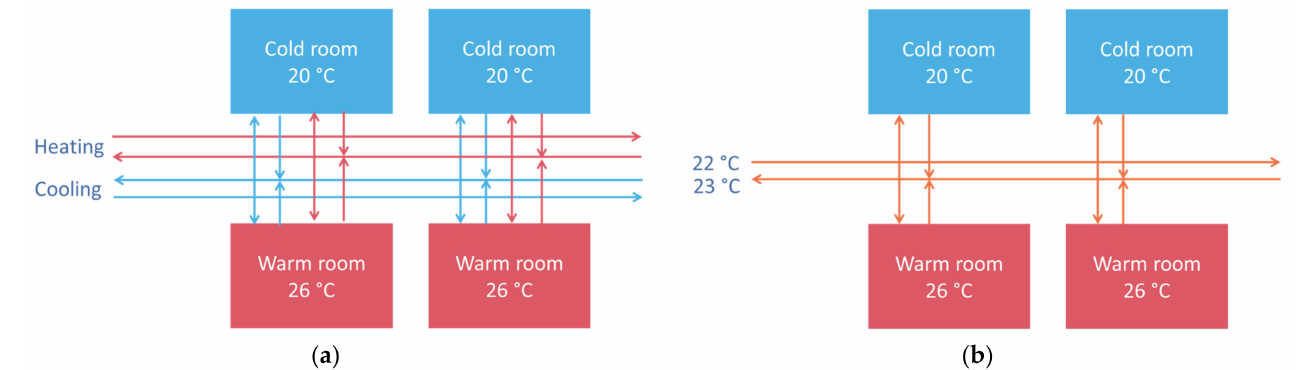
Figure 2. Pipe layout of ( a ) a standard heating and cooling solution with four pipes and controls; ( b ) a two-pipe layout with simultaneous heating and